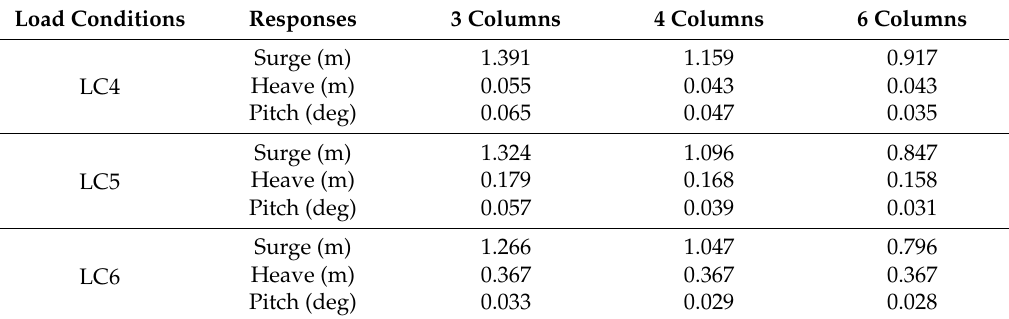
Figure 11. Pitch response for all three platforms under wave loadings ( a ) LC1, ( b ) LC2, and ( c ) LC3.